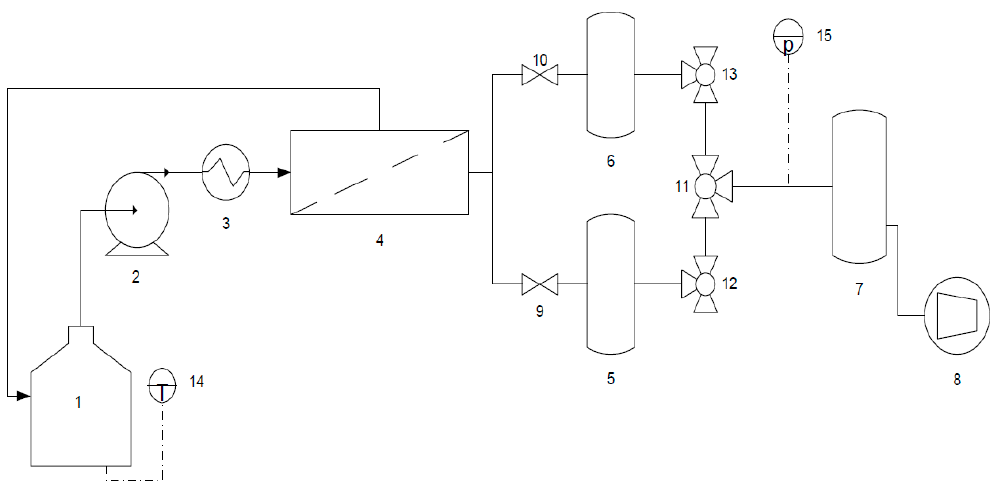
Figure 2. Pervaporation process set-up: (1) Feed tank ; (2) Volumetric pump ; (3) Heat exchanger ; (4) Membrane ; (5,6) Cold traps with liquid nitrogen ; (7) Safety trap ; (8) Vacuum pump ; (9,10) Simple valve ; (11,12,13) 3-way valves ; (14) Temperature sensor (±0.2 °C from − 30 to 120 °C) ; (15) Vacuum pressure sensor (<± 10% from 10 − 2 to 20 mbar).